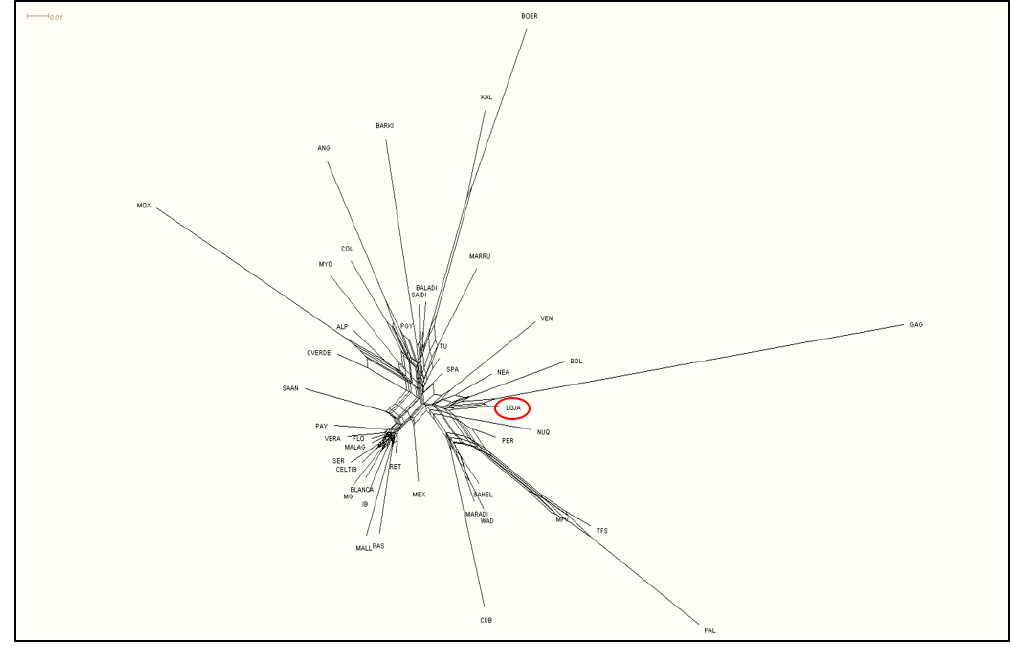
Figure 4. Neighbor-Net representation of Reynolds’ genetic distances between 43 goat populations.